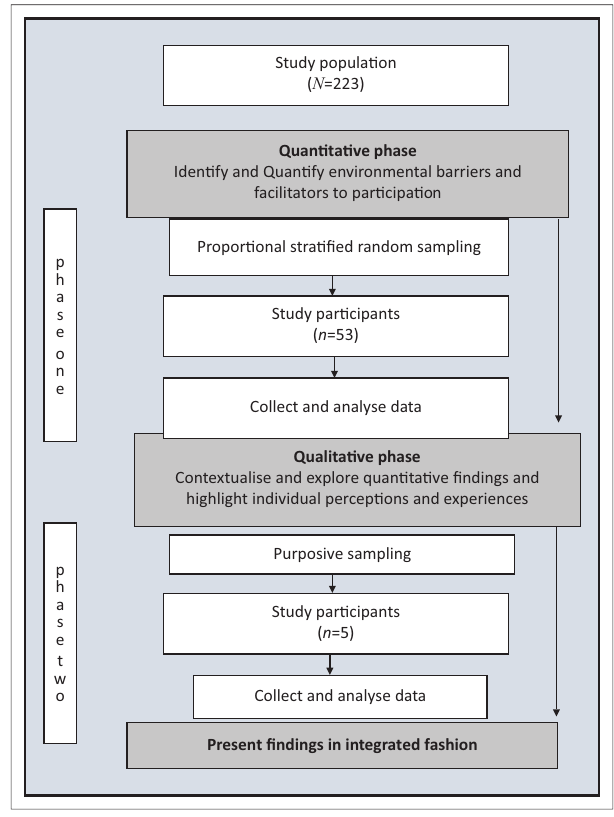
FIGURE 1: Diagrammatic presentation of the mixed method design with sequential explanatory